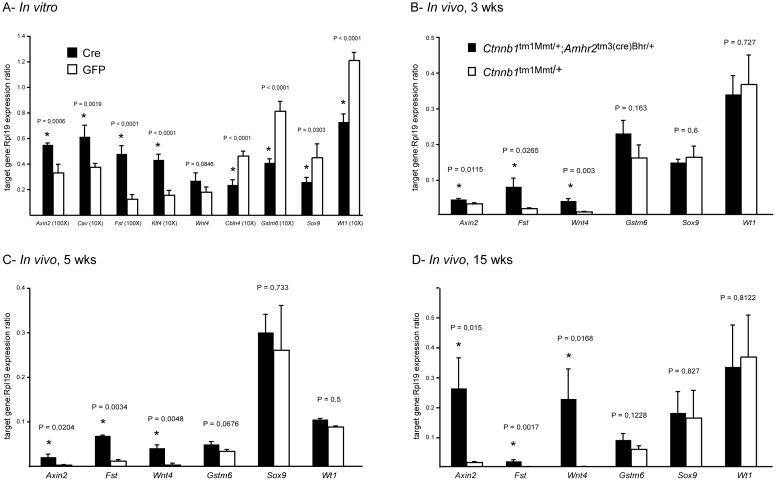
Expression and regulation of CTNNB1 target genes.(A) Quantitative RT-PCR analysis of the expression of the indicated genes in cultured Ctnnb1
tm1Mmt/tm1Mmt Sertoli cells treated with the Ad-eGFP (control) or Ad-Cre adenovirus, n = 4 samples/treatment, performed in triplicate. (B–D) Quantitative RT-PCR analysis of the expression of the indicated genes in Sertoli cells isolated from testes of 3 week- (B), 5 week- (C) and 15 week- (D) old mice, n = 4 animals/genotype/time point performed in triplicate. All data were normalized to the housekeeping gene Rpl19, and are expressed as mean (columns) ± SEM (error bars). Relevant P values are indicated, and accompanied with an asterisk (*) when significant differences from controls (P<0.05) were detected.